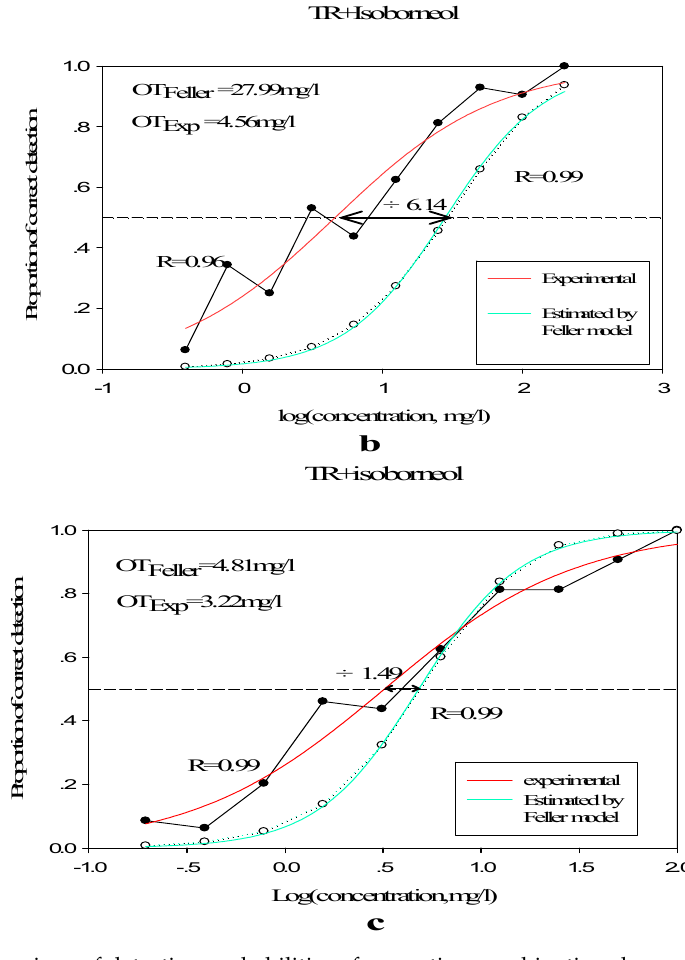
Figure 3. Comparison of detection probabilities of aromatic recombinations by experiments and by feller’s model. OT Feller , olfactory threshold measured by Feller’s additive model; OT Exp , experimental olfactory threshold. ( a – c ) Adding isoborneol at high, medium, and low level respectively.